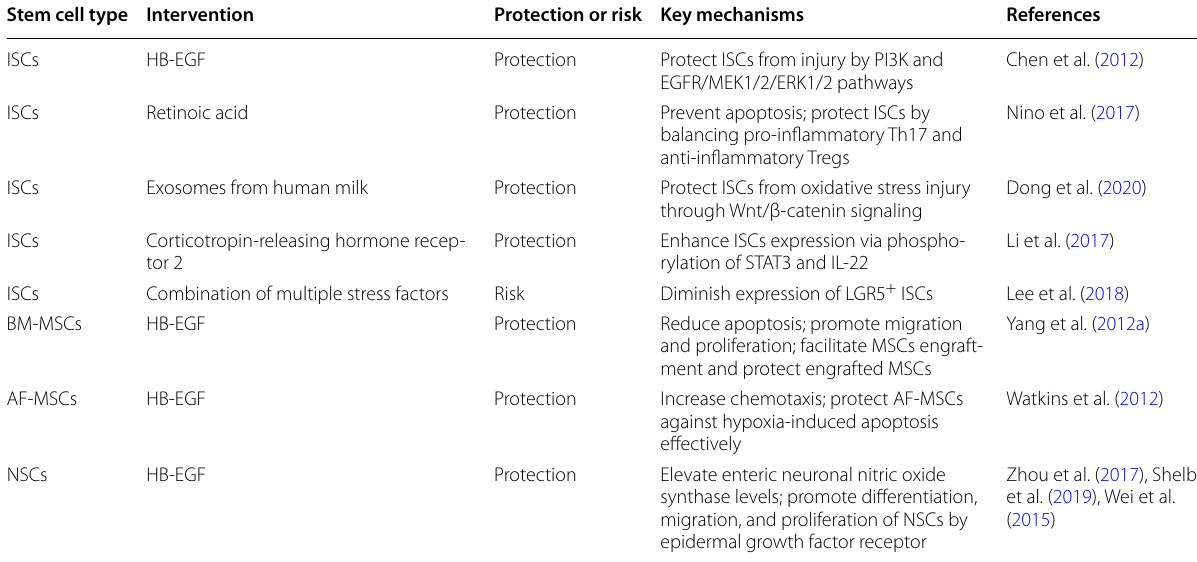
Table 3 Factors influencing stem cell therapy in NEC Stem cell type